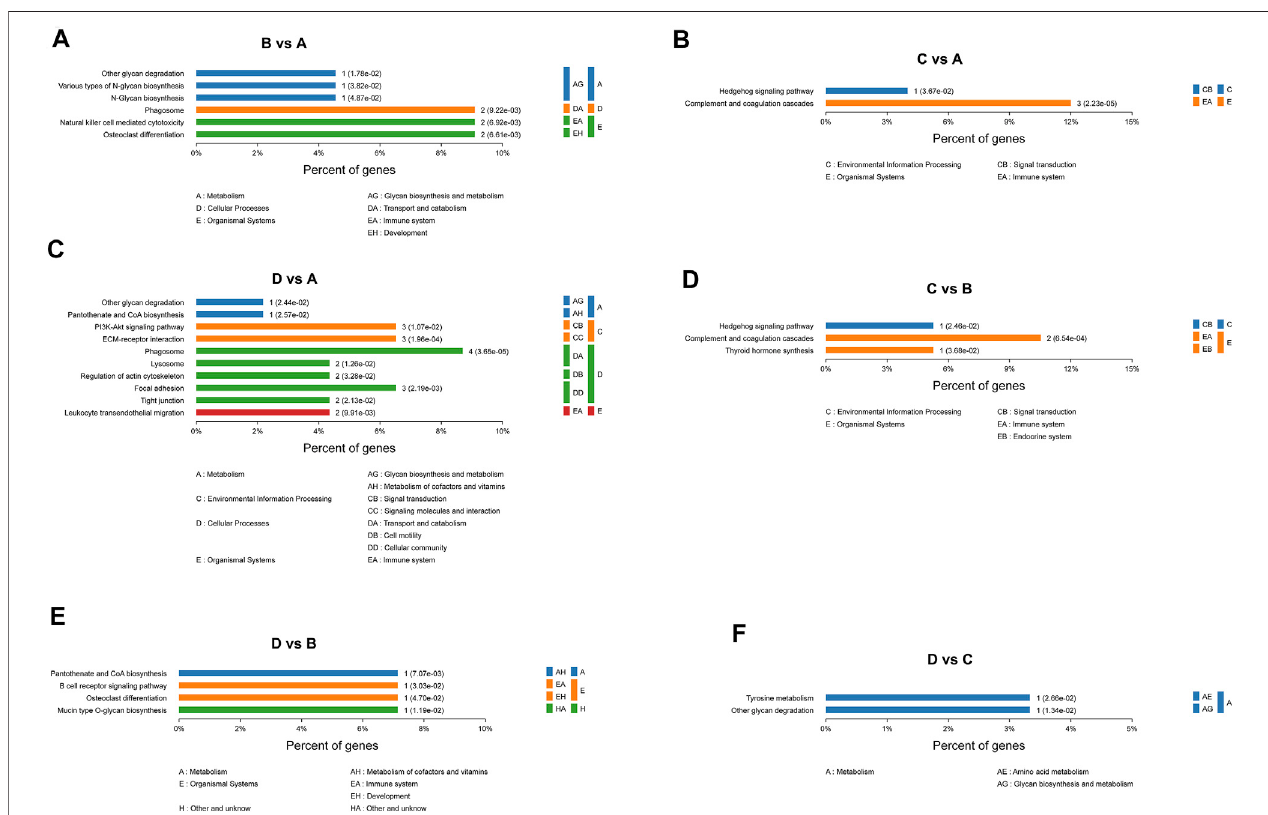
FIGURE 7 | KEGG enrichment analysis of differentially expressed proteins: (A) group B (mild OSA) vs group A (non-OSA), (B) group C (moderate OSA) vs group A (non-OSA), (C) group D (severe OSA) vs group A (non-OSA), and (D) group C (moderate OSA) vs group B (mild OSA), and (E) group D (severe OSA) vs group B (mild OSA), and (F) group D (severe OSA) vs group C (moderate